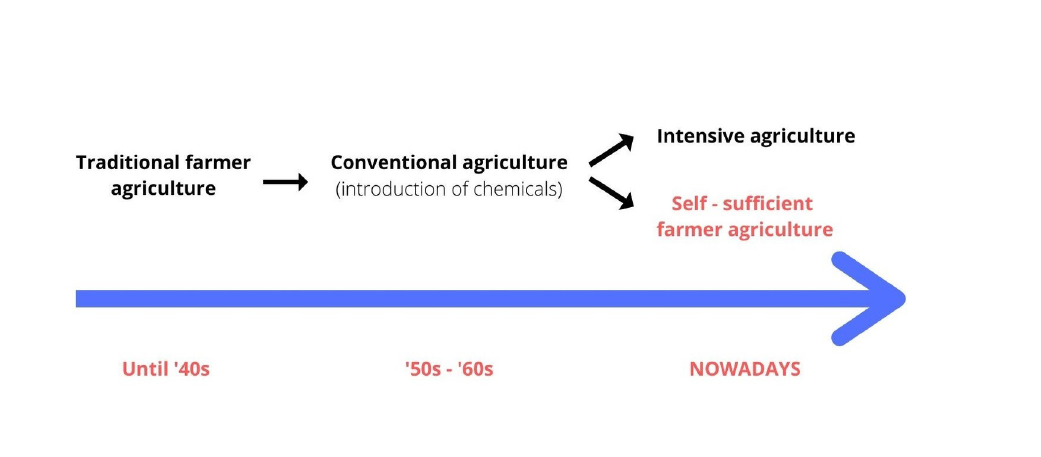
Fig. 7. Farmer agriculture evolution in the last Century